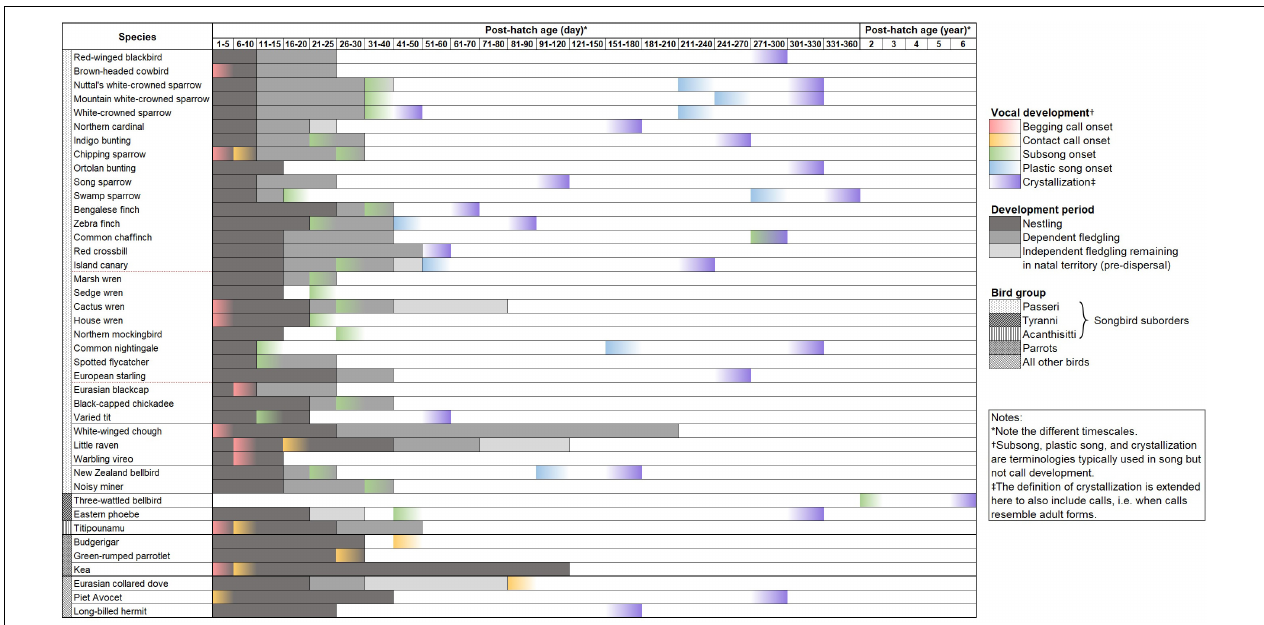
FIGURE 2 | Bird species [ordered from derived clades at the top to older clades at the bottom following Oliveros et al. (2019)] with published vocal development data, showing the onset of vocal development stages and the first instance of crystallization, which excludes subsequent adult learning and crystallization, e.g., in seasonal birds such as Island canaries (see Supplementary Data 1 for citations). This data shows that closely related songbird species can have different vocal development patterns, and that there is a lack of representation of suboscines. Parrots are added for comparison with songbirds, as parrots are vocal learners that mainly have calls. Some non-oscine non-learners such as Eurasian collared dove and pied avocets are also included for comparisons between learners and non-learners. The other song learning group, the hummingbirds, is only represented by one species, the long-billed hermit, but is added for completeness of data. On the species column, classifications follow Oliveros et al. (2019); thick horizontal solid lines separate bird orders, thin horizontal solid lines separate different suborders within songbirds and parrots, and red dashed lines separate parvorders in songbirds. Future research contributing to this dataset by adding underrepresented species will be critical to quantify the variation on vocal development periods and potentially producing a method to systematically sort species along the vocal learning